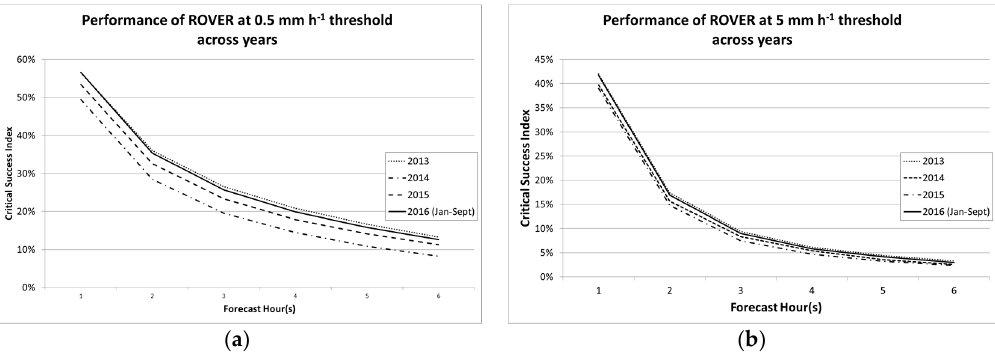
Figure 10. Across year comparison of the performance of ROVER at: ( a ) 0.5 mm · h − 1 ; and ( b ) 5 mm · h − 1 thresholds for forecast range of 1–6